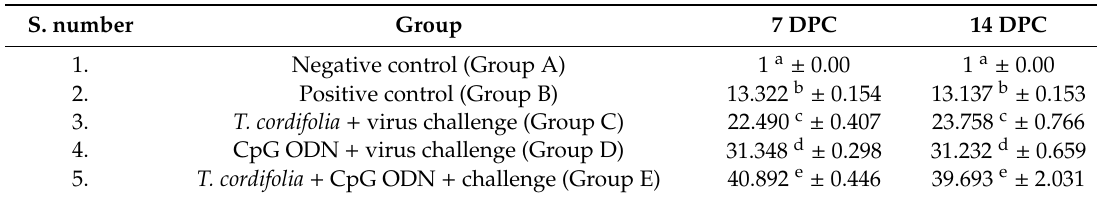
Table 8. Quantitative real time PCR analysis of IFN- γ expression in the bursa of Fabricius of chickens challenged with vvIBDV at di ff erent